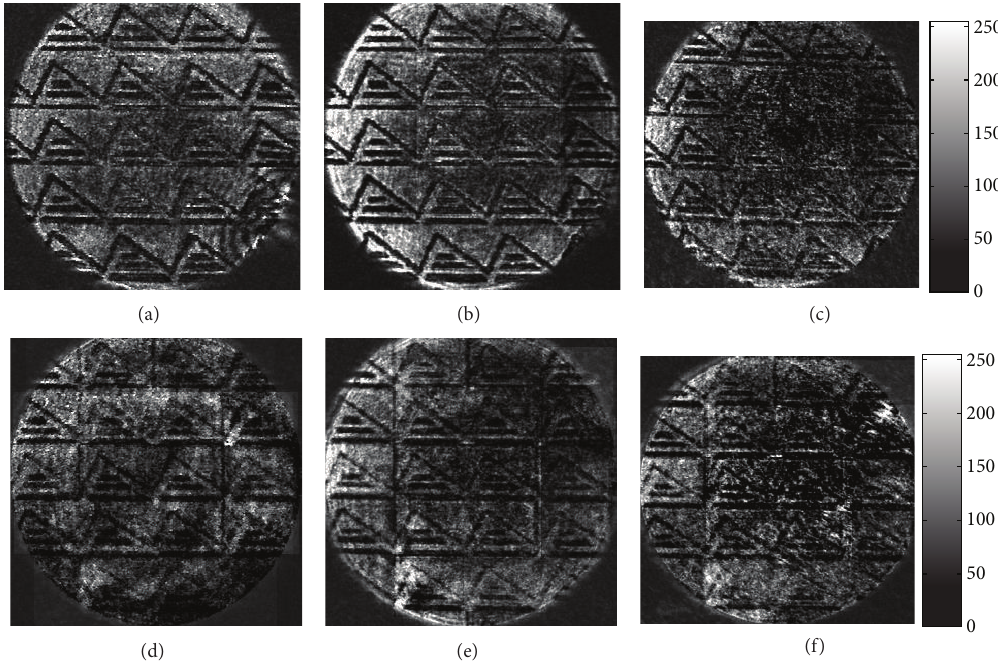
Figure 8: Object of LOGO UA: ((a), (b), and (c)) images of the holograms numbers 1, 5, and 15, respectively, stored with BIM. ((d), (e), and (f)) Images of the holograms numbers 1, 5, and 15, respectively, stored with HTM.